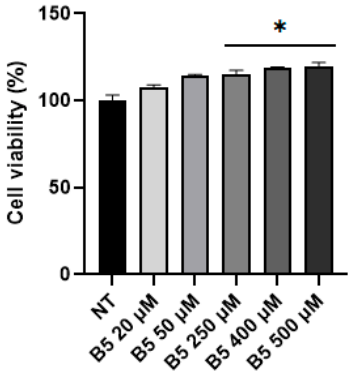
Figure 7. MTS assay on Caco-2 cells at 4 h p.t. Asterisk indicated p < 0.05 (*) compared with non- treated (NT) cells, ANOVA One-Way test. Analysis was performed on three independent biological replicas. Data are reported as mean ± SEM.